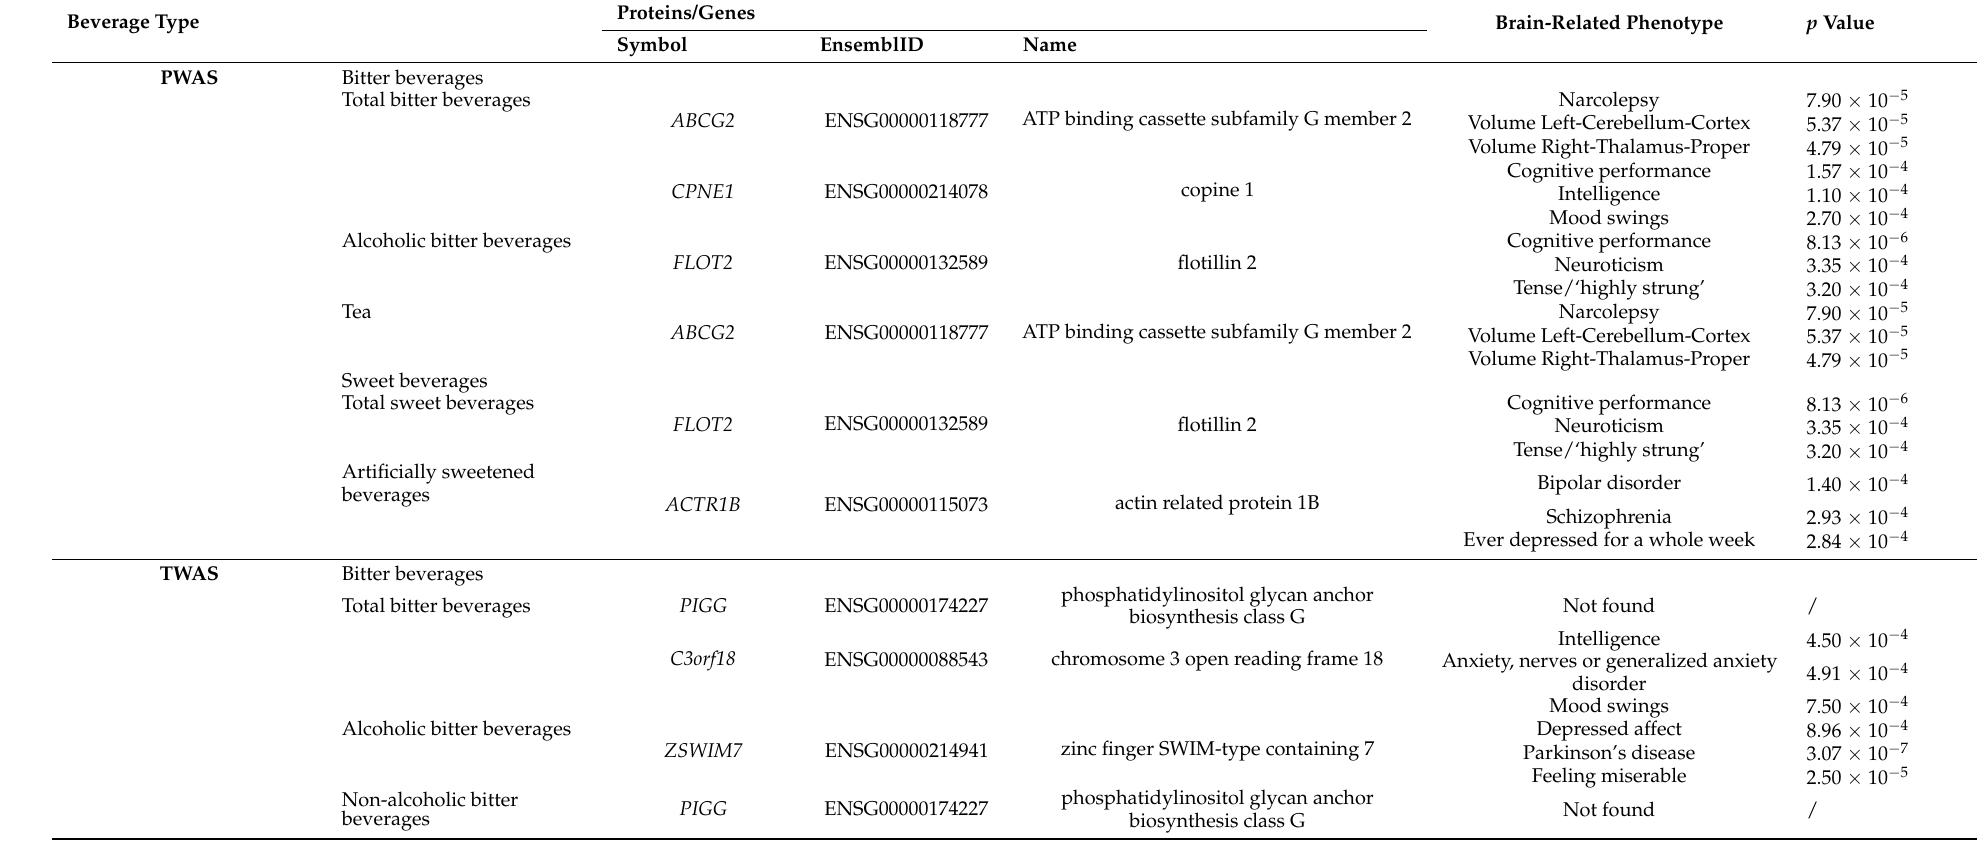
Table 2. Brain-related phenotype of significant proteins or genes identified by PWAS and TWAS